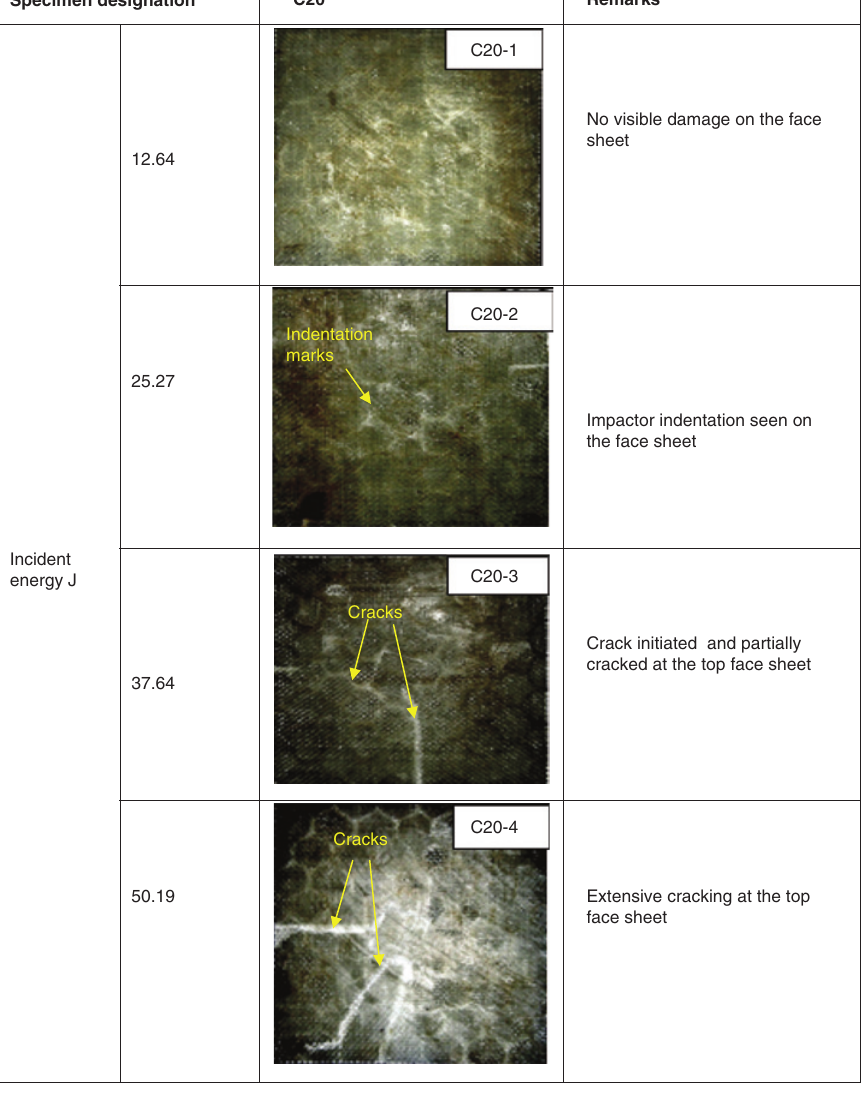
at 50.19 J. Figure 13 shows photographs of 20 mm cell size specimens impacted at different energy levels. No visible damage on the top face sheet is observed at 12.64 J. At about 25.27 J, an impactor indentation is seen on the top face sheet, and extensive cracking on the top face sheet is seen at 50.19 J. For the 25 mm cell size specimen, an impactor indentation is seen on the top face sheet even at 12.64 J. At 25.27 J, cracks are seen on the top face sheet, and severe debonding and crushing of the core is seen at 50.19 J which is shown in Figure 14. At 12.64 J incident energy, there is no visible damage on the top face sheet except for the C25 cell size specimen. Upon increasing the energy level to 25.27 J, an impact